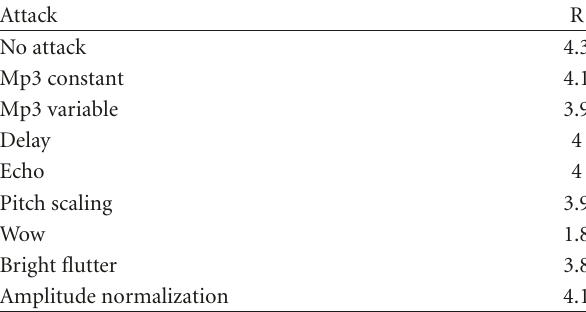
Table 3: The measures of detection